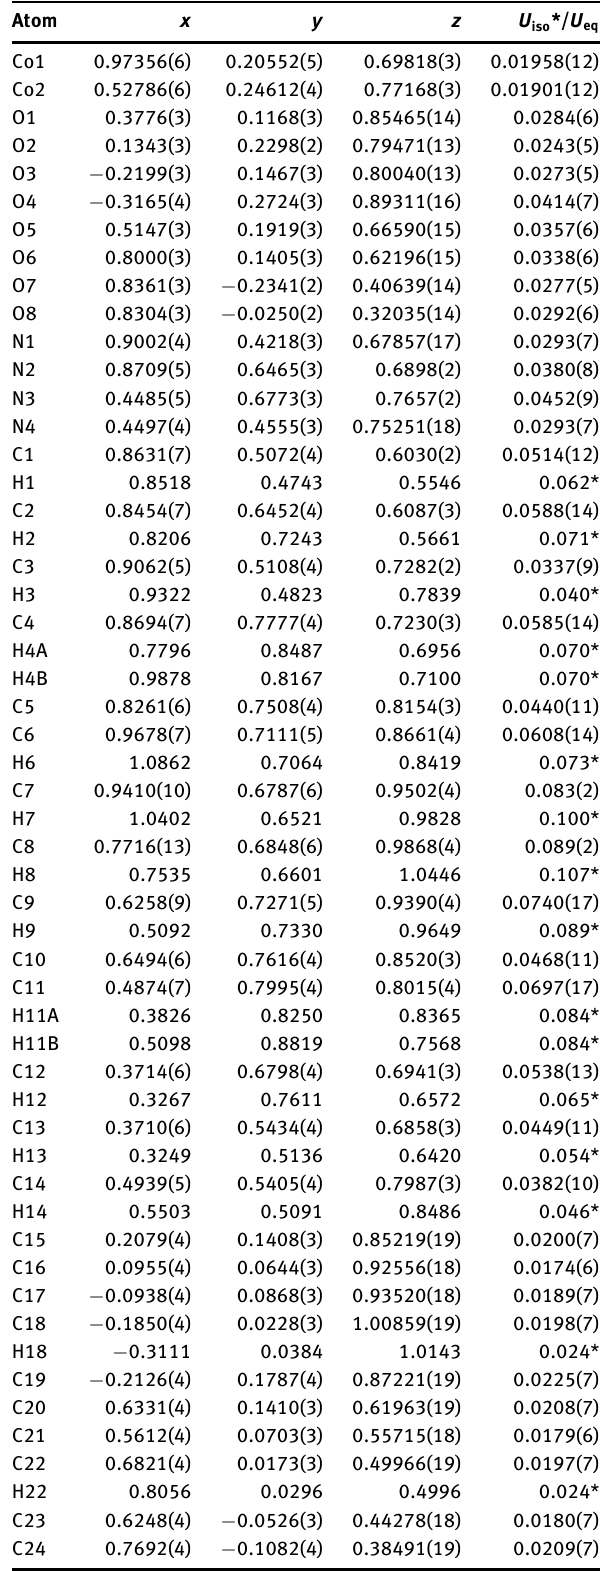
Table 2: Fractional atomic coordinates and isotropic or equivalent isotropic displacement parameters (Å 2